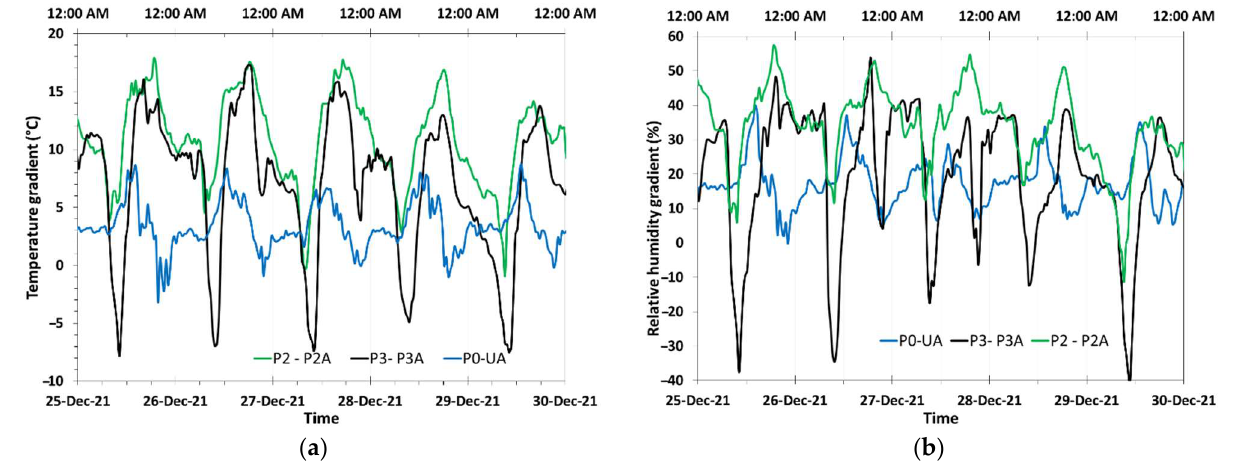
Figure 6. Temperature and relative humidity vertical gradients in 3 different sites expressed as dif-